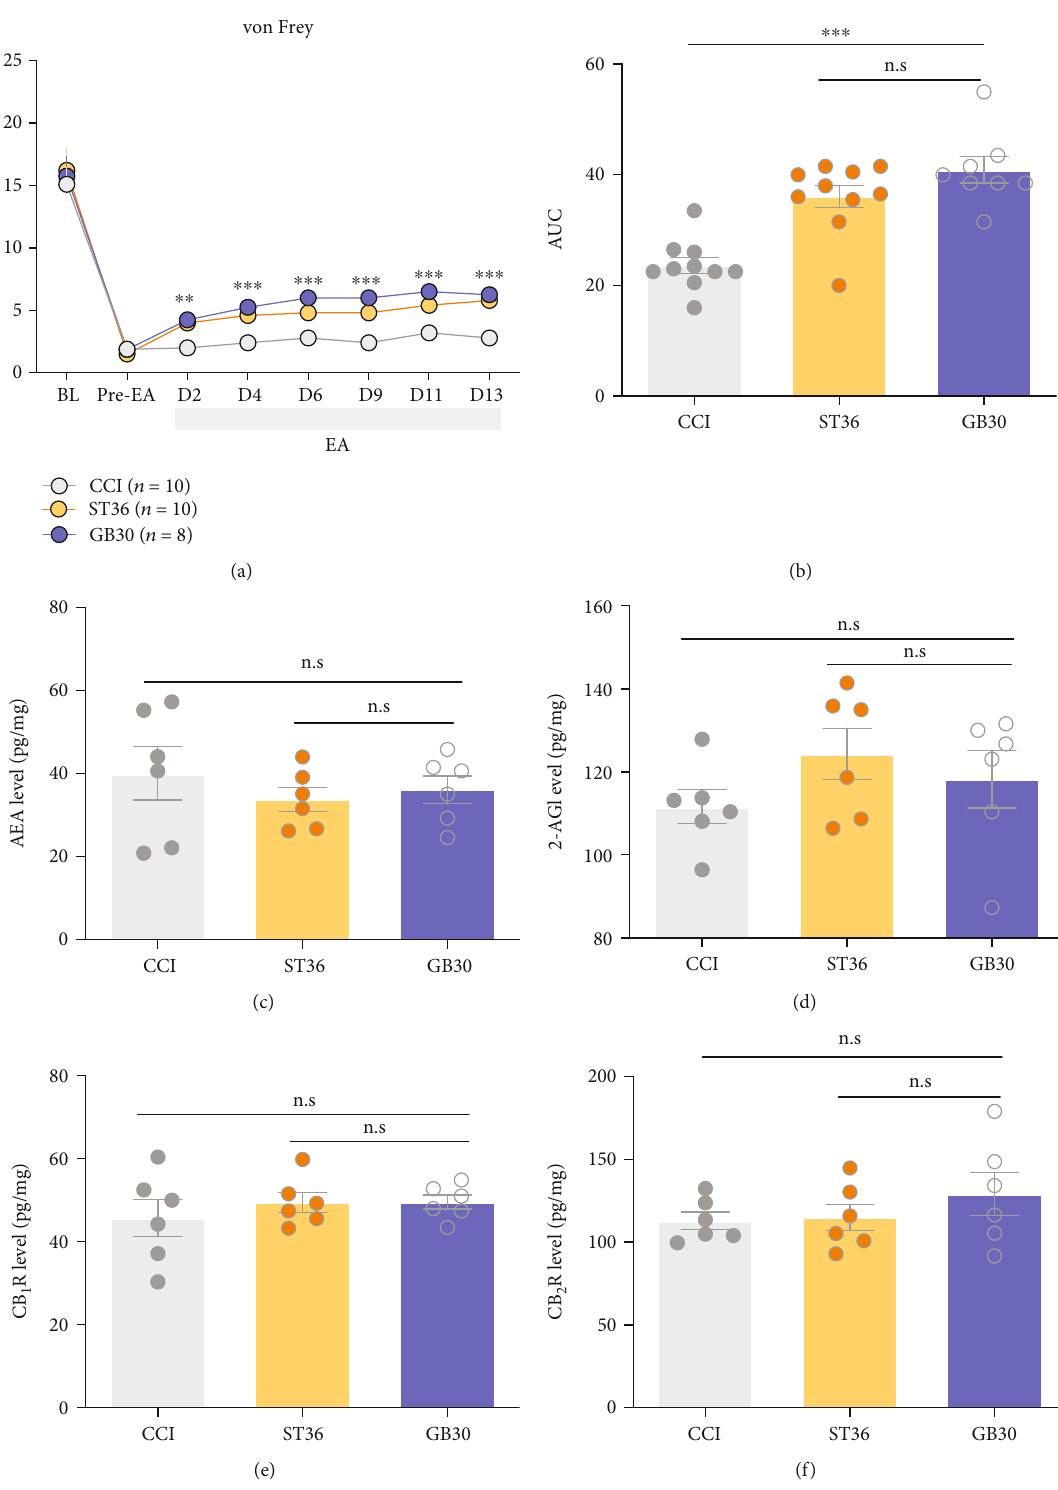
R (e), and CB R (f) which activate the endocannabinoid system. All data 1 2 : cannabinoid receptor 1; CB : 1 2